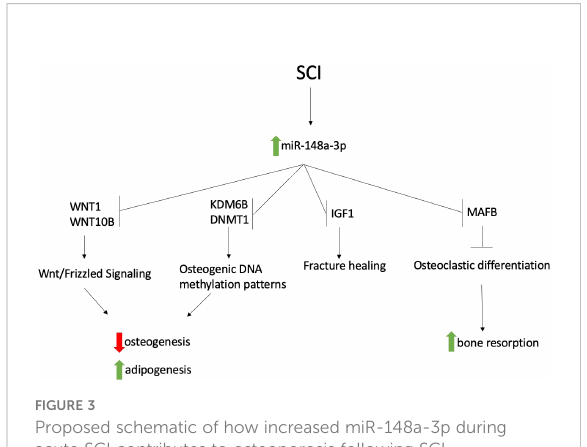
FIGURE 3 Proposed schematic of how increased miR-148a-3p during acute SCI contributes to osteoporosis following